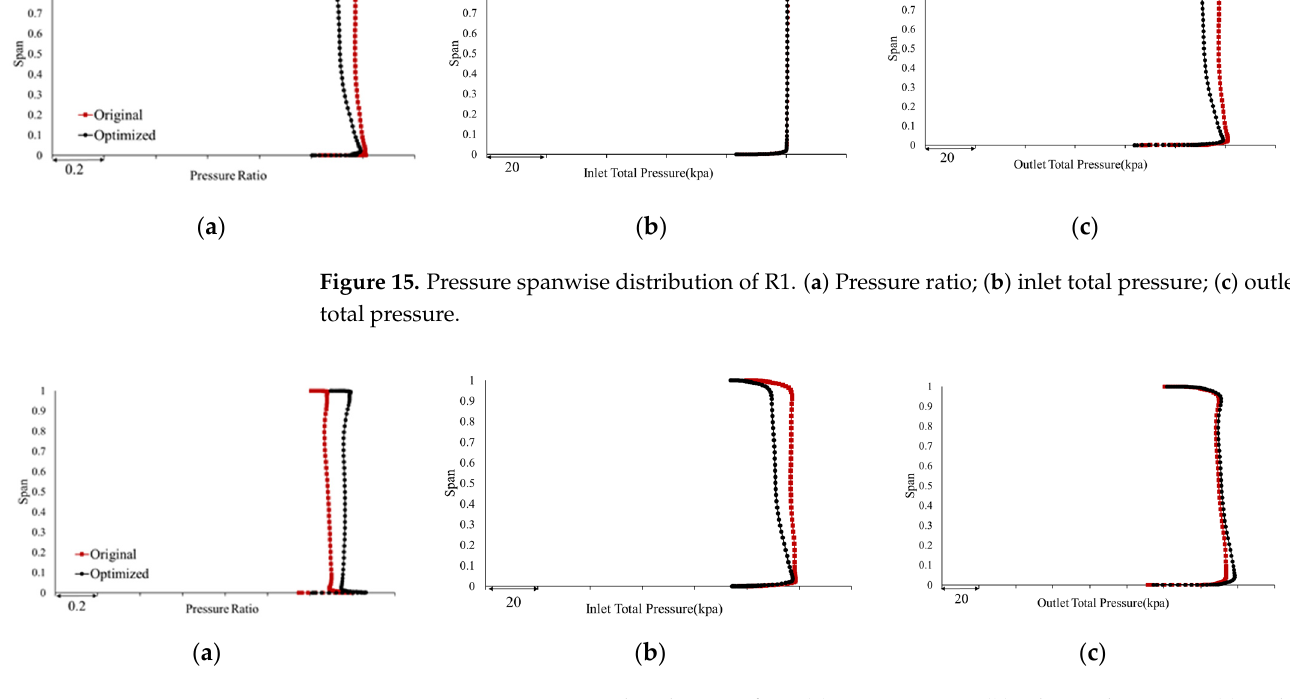
Figure 16. Pressure spanwise distribution of R2. ( a ) Pressure ratio; ( b ) inlet total pressure; ( c ) outlet total